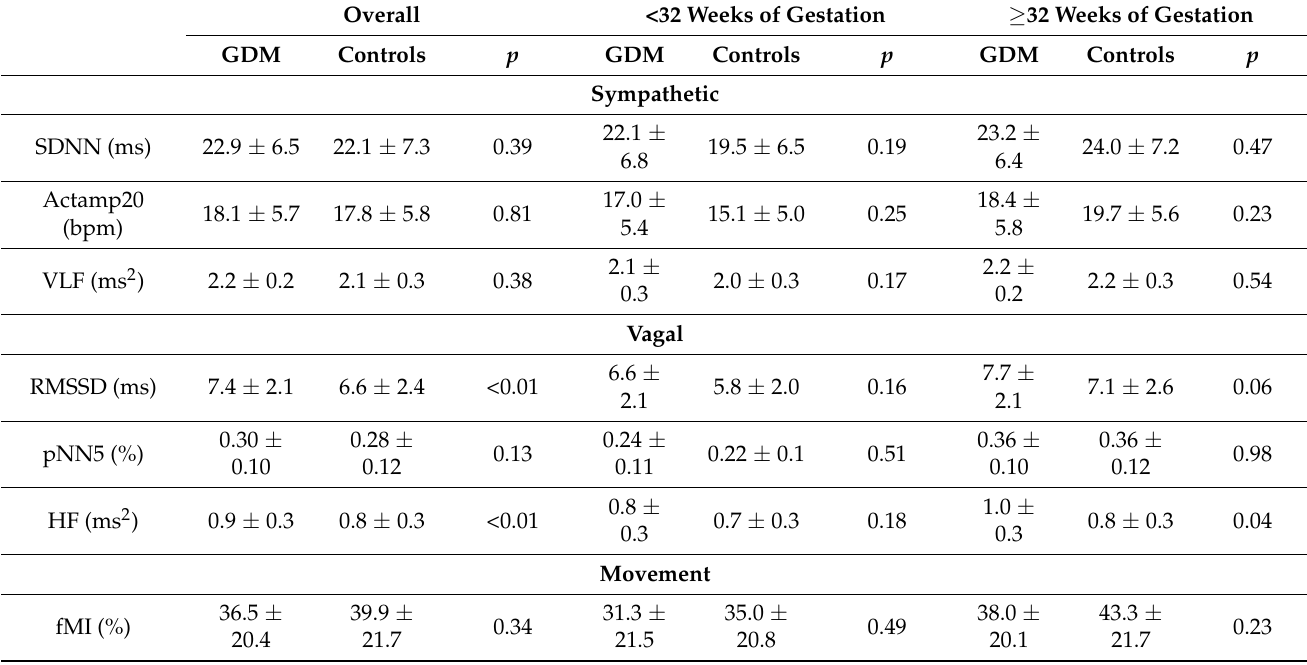
Table 3. Results of HRV analysis and fMI ( ± standard deviation) in the study cohort (GDM) and comparison to controls. Overall (independent of gestational age), <32 weeks of gestation and ≥ 32 weeks of gestation, p -values were calculated using Mann-Whitney U or t -test depending on normal